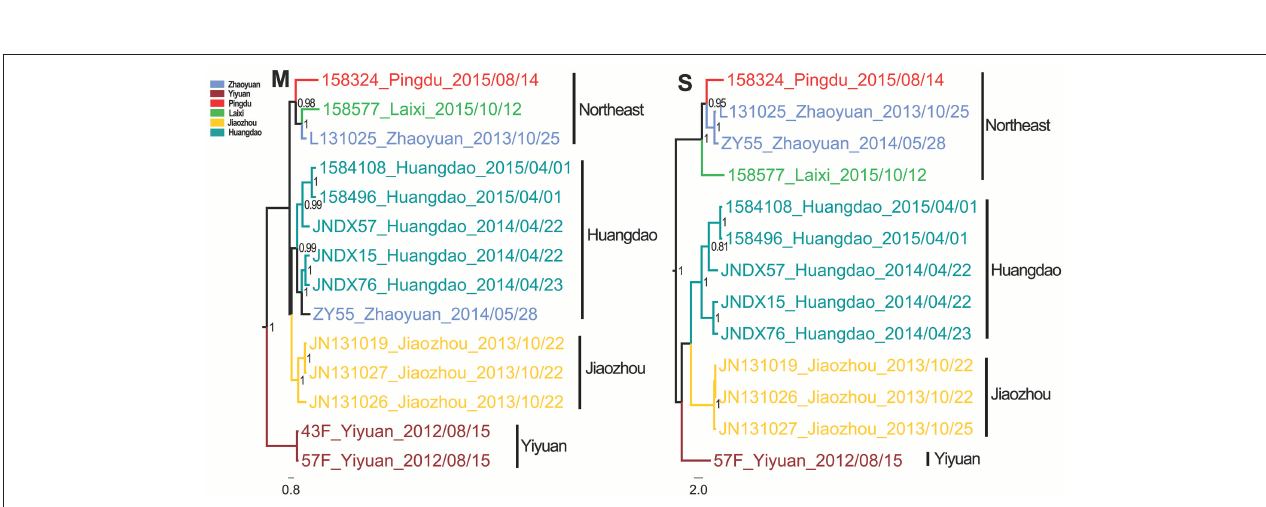
FIGURE 3 | Relative phylogenetic relationships of M and S gene sequences for Seoul virus defined in MCC trees. Different colors represent the geographic origin of the samples. Numbers at each node are posterior probabilities (PP) based on 6,000,000–12,000,000 trees. Only PP values > 0.6 are shown. The scale bar indicates the nucleotide substitutions per site.